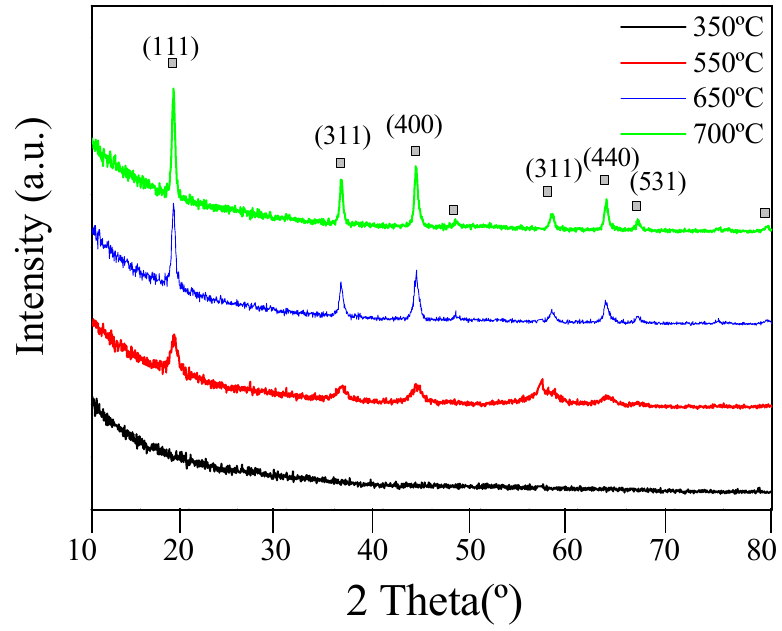
Figure 4. X-ray di ff raction patterns of mesoporous Li 4 Ti 5 O 12 thin films heat-treated at di ff erent temperatures under argon